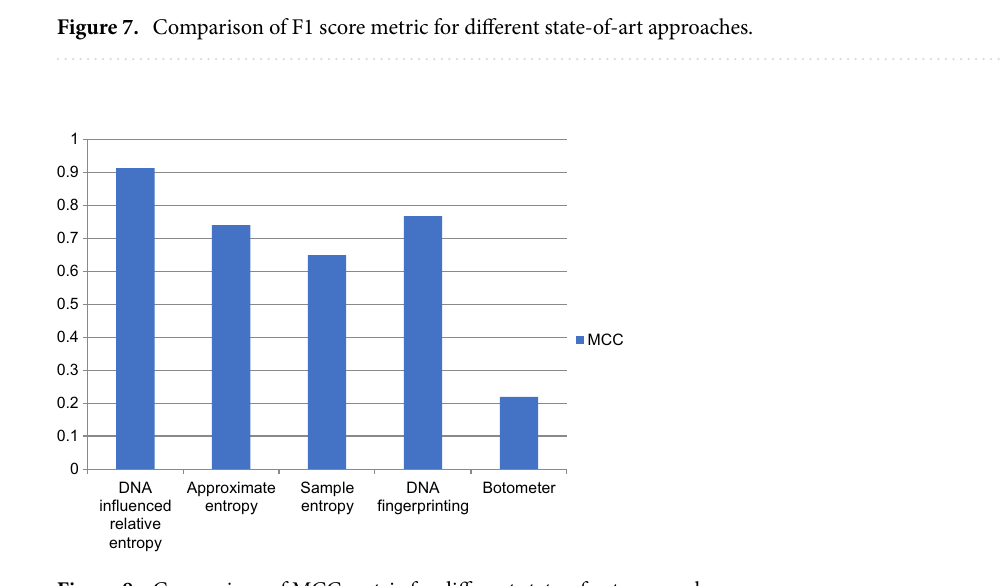
Figure 8. Comparison of MCC metric for different state-of-art